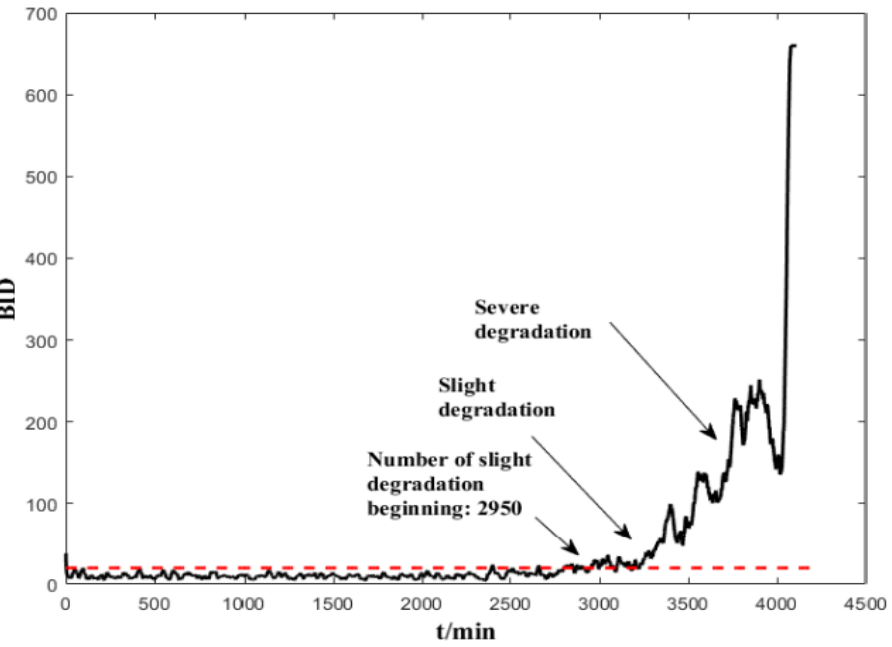
Figure 16. Performance evaluation of complete life of a bearing through time [47].